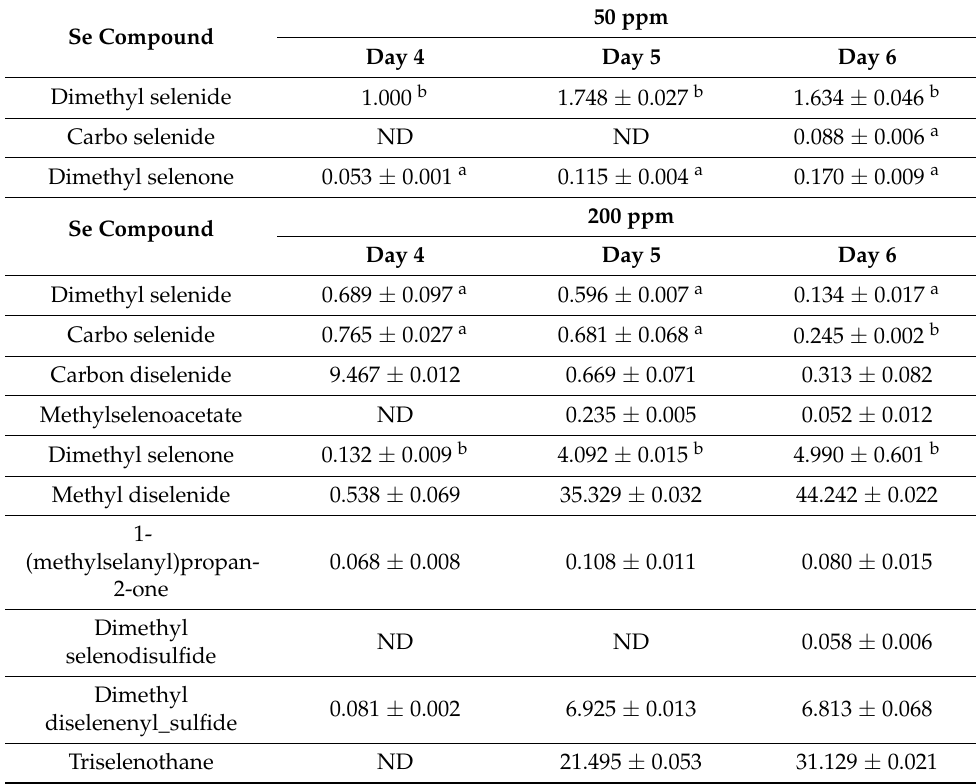
Table 1. Volatile Se compounds of Ganoderma lucidum in the liquid culture process. Se